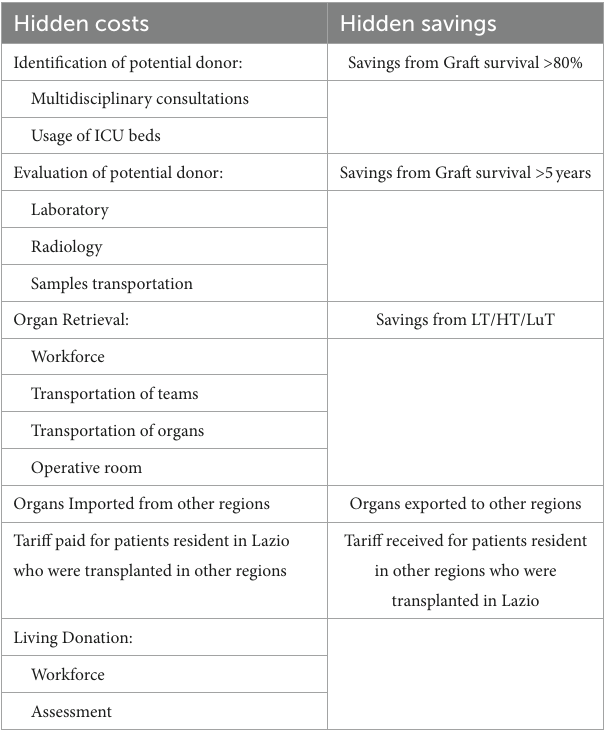
TABLE 5 Costs and Savings related to Organ Donation and Transplantation not clearly reported. Hidden